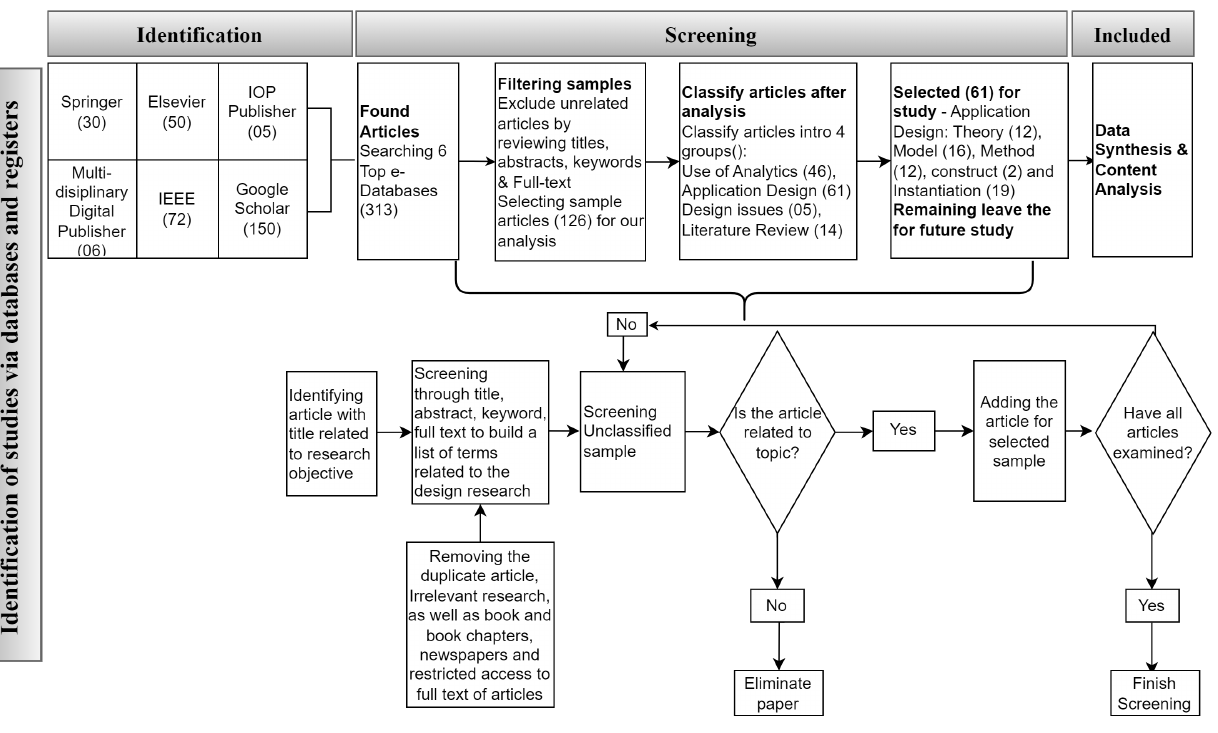
Figure 1. Proposed systematic review for sample collection and